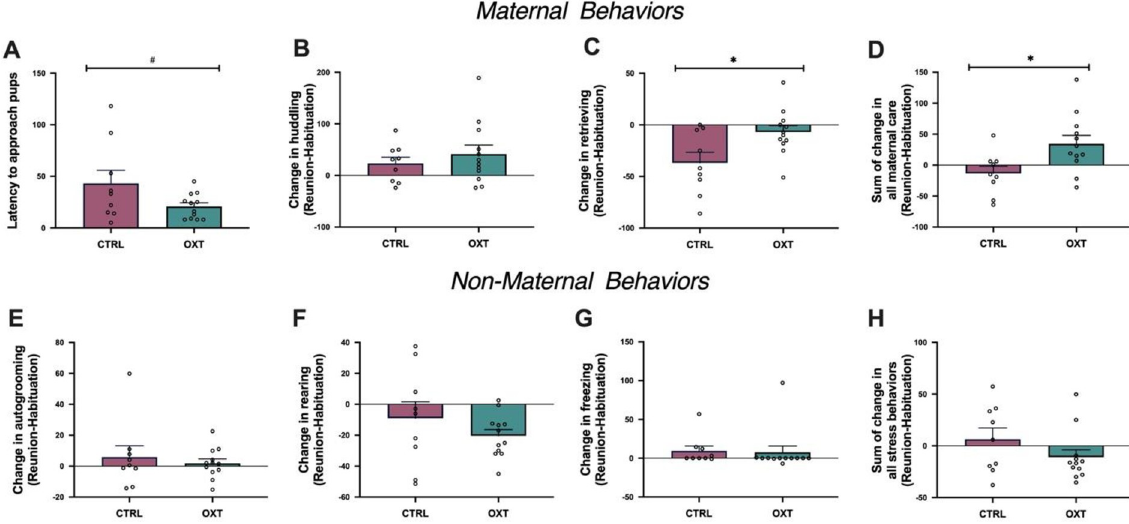
Fig 3. Rapid effects of OXT on change in maternal and non-maternal behavior from habituation to reunion. Maternal behaviors : (A) There was a non-significant trend for mothers given IN OXT to have a shorter pup approach latency. (B) There were no treatment differences for maternal huddling. (C) Mothers given IN OXT showed a significantly greater decrease in retrieval/carrying behavior from the habituation to the reunion phase. (D) IN OXT had a net positive effect on total maternal care relative to controls from the habituation to reunion phases. Non-maternal behaviors : (E) There were no treatment effects for change in autogrooming, (F) rearing, or (G) freezing. (H) There was no net change in non-maternal behaviors from the habituation to reunion. Correlation line collapsing across treatment groups. � p < 0.05; #p < 0.10.